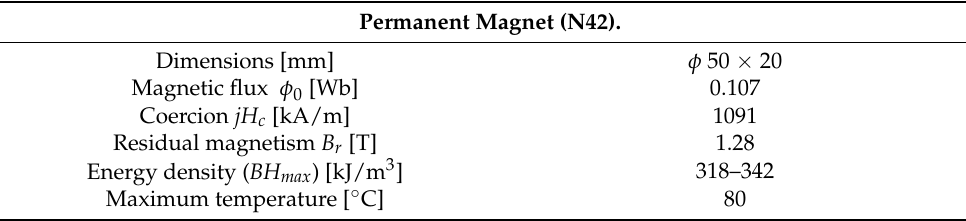
Table 2. Characteristics of permanent magnets